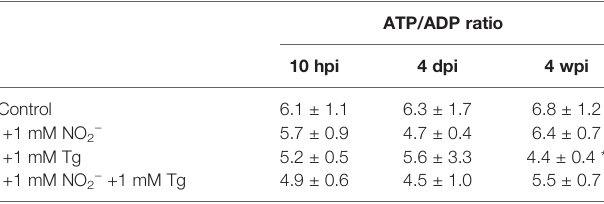
TABLE 2 | Effects of NR effectors on ATP/ADP ratio in Medicago truncatula roots and